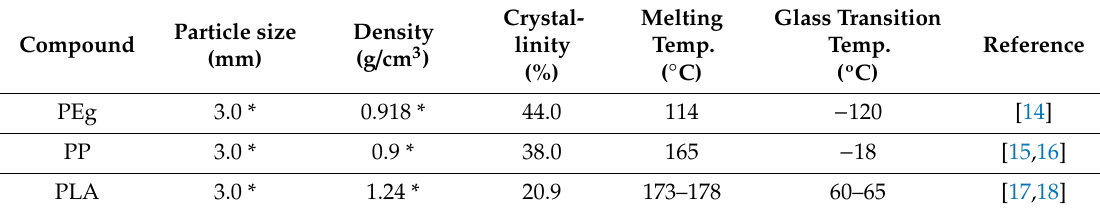
Table 1. Physico-chemical properties of the investigated